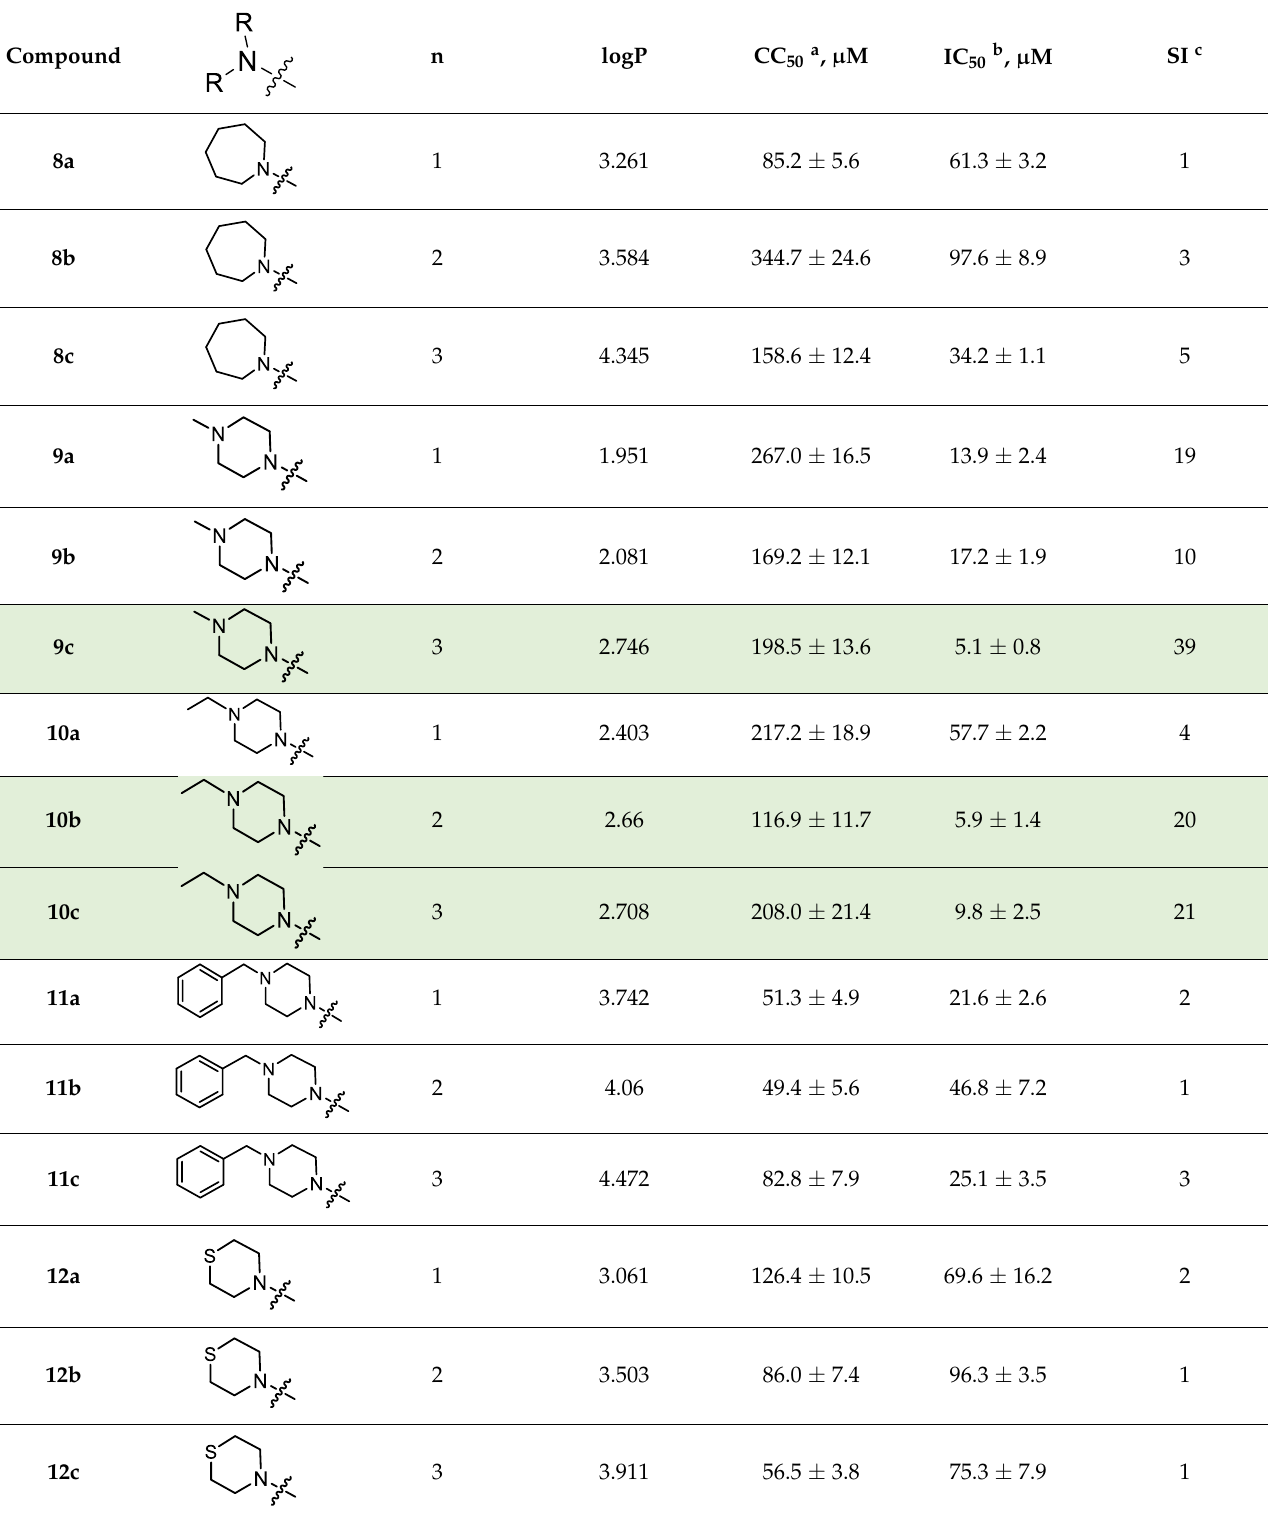
Table 2. Cont. Table 2. In vitro anti-RSV activity, cytotoxicity, and logP values for compounds 3 – 15a – c